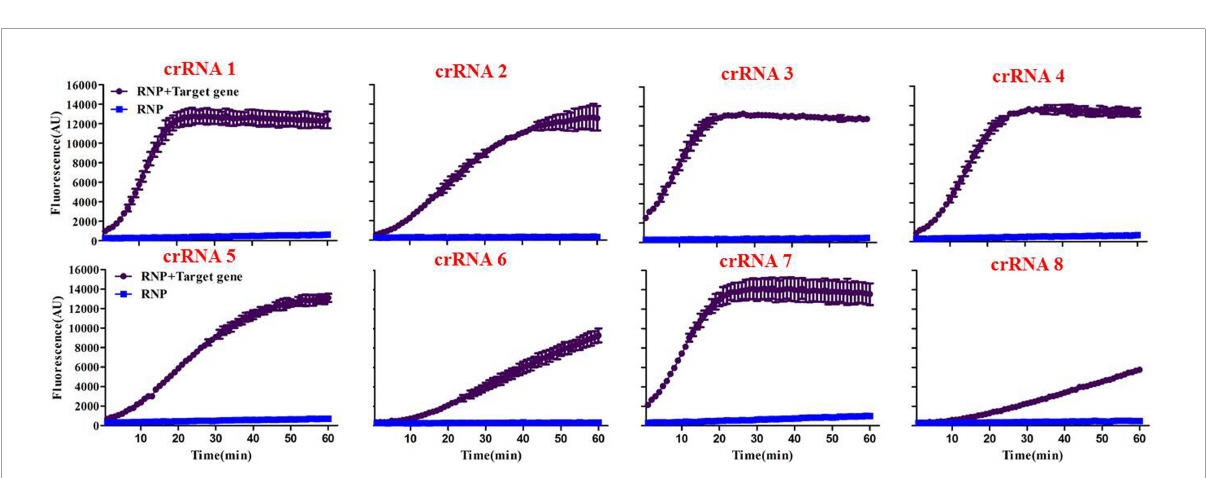
FIGURE3 Screening of specific crRNAs by the Card platform. The performance of crRNA 1 to crRNA 8 was determined by testing 50 nM of each RNP individually against 10 5 copies/ µ L of plasmid including a conserved region of the A. pleuropneumoniae -specific apxIVA gene. RNP = no target DNA in the reaction system. Data are represented as mean ± standard